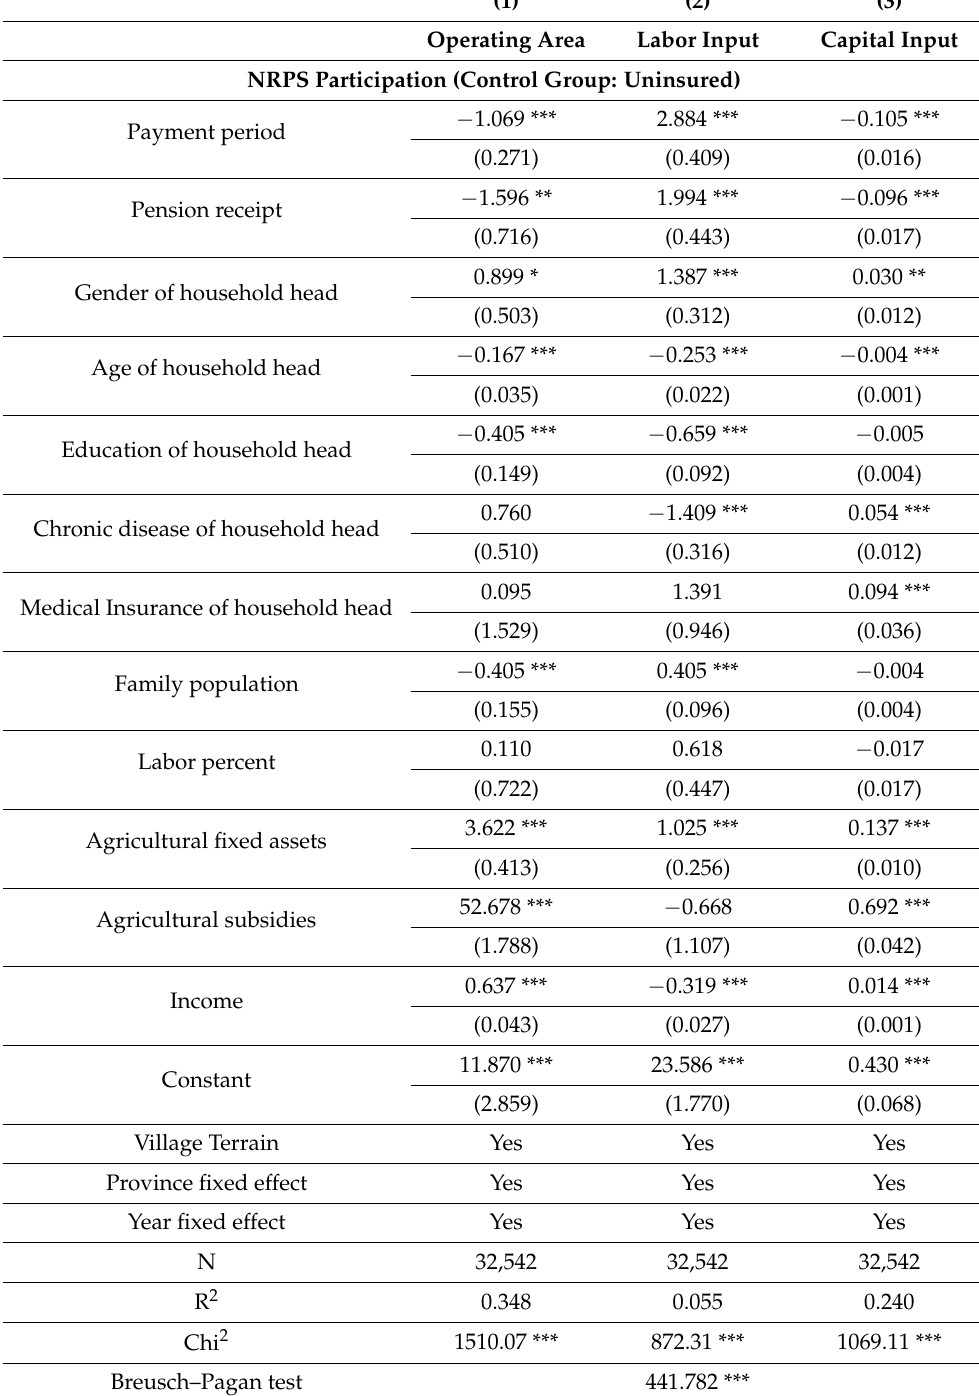
Table 2. Benchmark regression